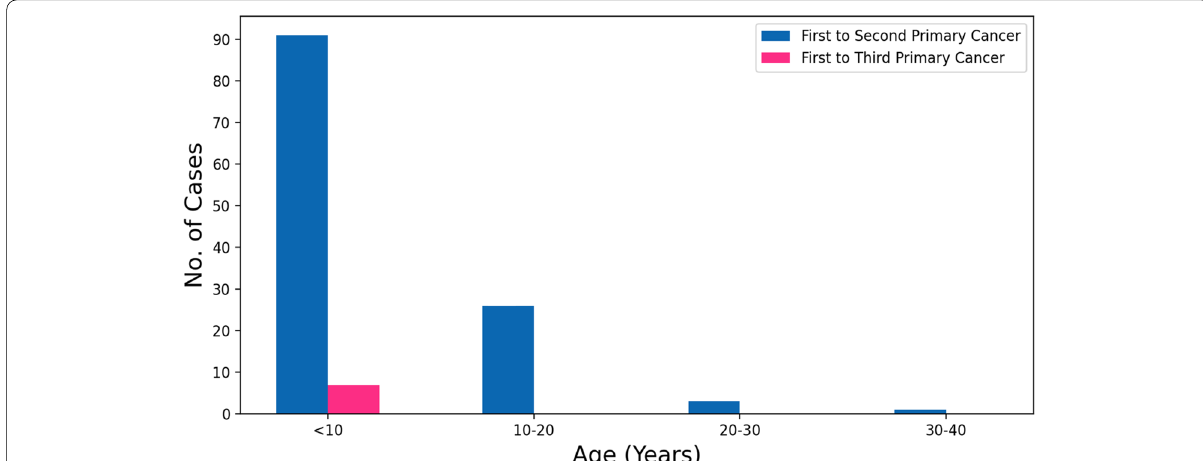
Fig. 2 Graph showing the interval between the diagnosis of the first primary and second primary cancer & first primary and third primary